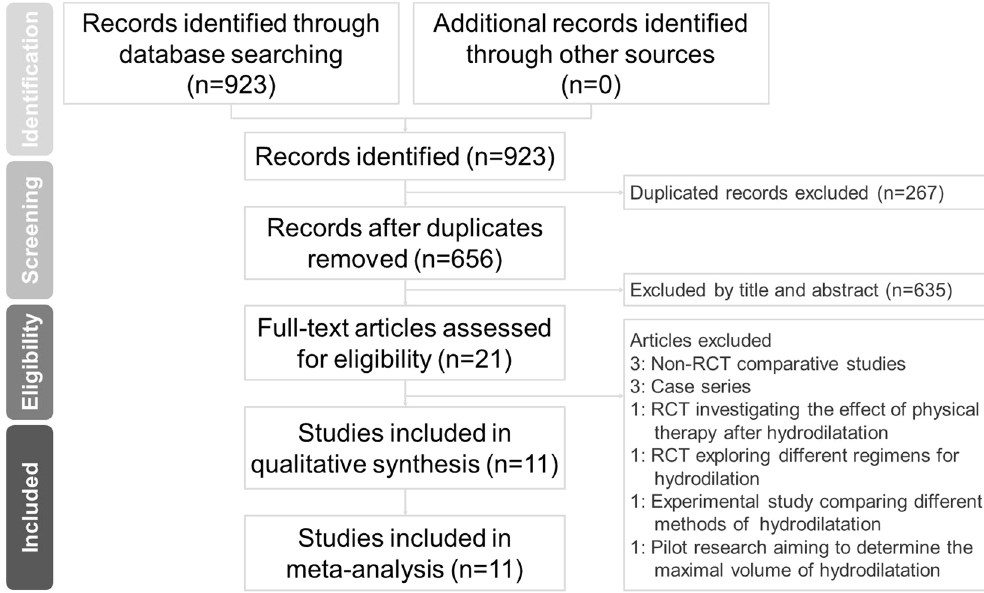
Figure 1. Flow diagram for the study selection process based on the suggestion format of Preferred Reporting Items for Systematic Reviews and Meta-Analyses